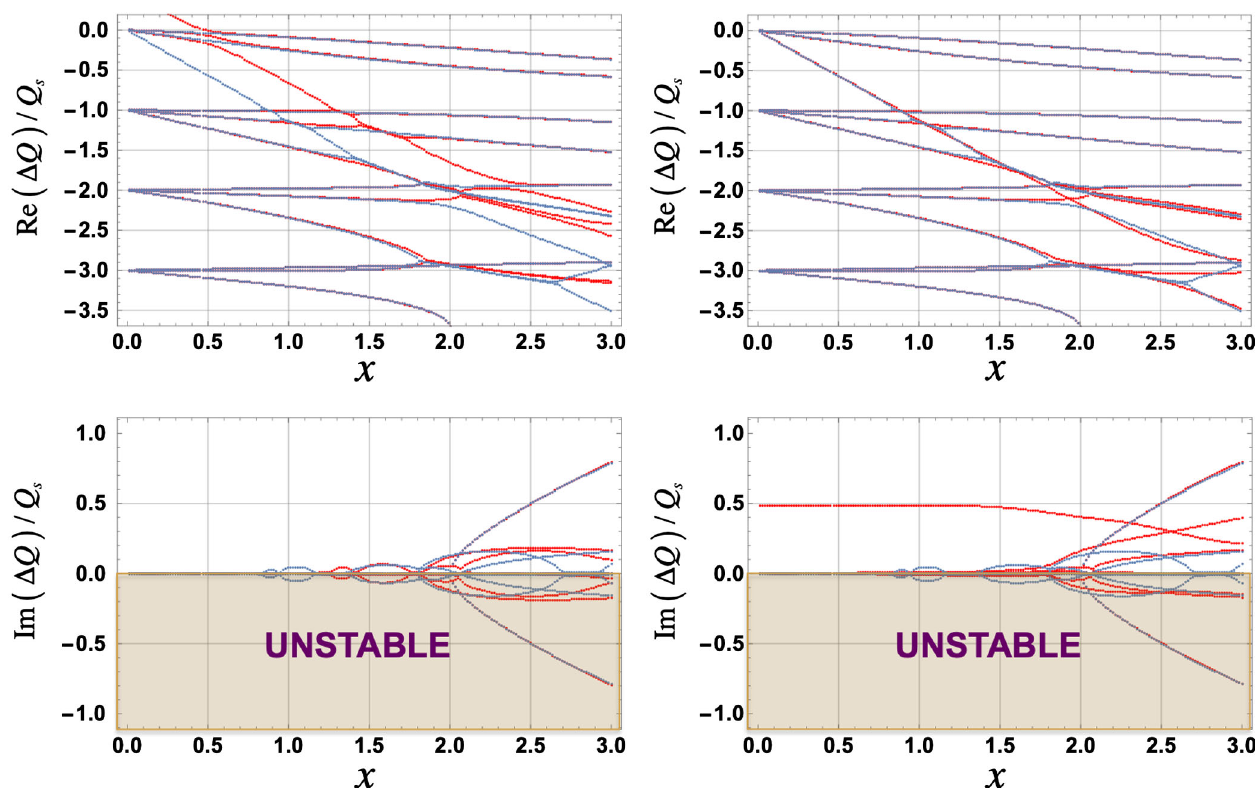
FIG. 2. Usual TMCI plots (showing the evolution of the real and imaginary parts of the complex tune shift solution of the eigenvalue problem, normalized by the synchrotron tune Q s , vs x a normalized parameter proportional to the bunch intensity [4]) from GALACTIC for the case of a bunch with a longitudinal “ water-bag ” distribution [19] interacting with a broad-band resonator impedance with a quality factor of 1 and a resonance frequency f r such that f r τ b ¼ 2 . 8 (long-bunch regime, with τ b the full, 4-sigma, bunch length). This approximately describes the CERN super proton synchrotron (SPS) case. Left: without TD in blue and with a reactive TD in red ( Δ Q TD =Q s ¼ 0 . 48 ); Right: without TD in blue and with a resistive TD in red ( Δ Q TD =Q s ¼ 0 . 48 j